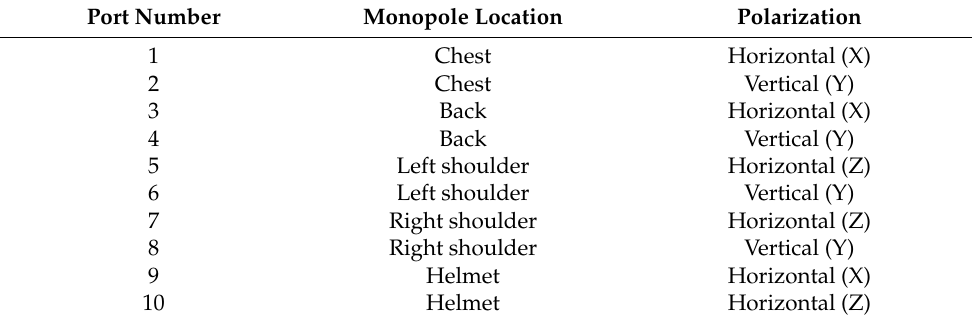
Table 2. Port numbering of the antenna system.